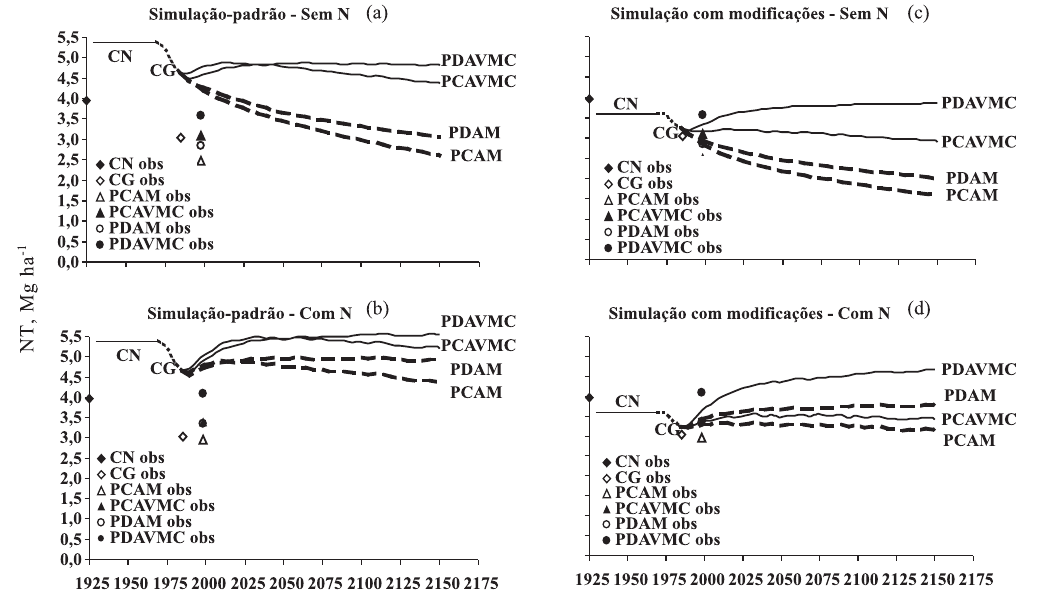
Figura 2. Evolução temporal dos estoques de nitrogênio total (NT) do solo nas simulações-padrão sem N mineral (a) e com aplicação de N mineral (b) e nas simulações com modificações sem N mineral (c) e com aplicação de N mineral (d) estimada pelo modelo Century 4.0 para os sistemas de preparo de solo e sistemas de culturas, comparada aos dados apresentados por Lovato (2001) para os anos de 1985 e 1998. CN: campo nativo; CG: colza/girassol; PC: preparo convencional; PD: plantio direto; A: aveia;